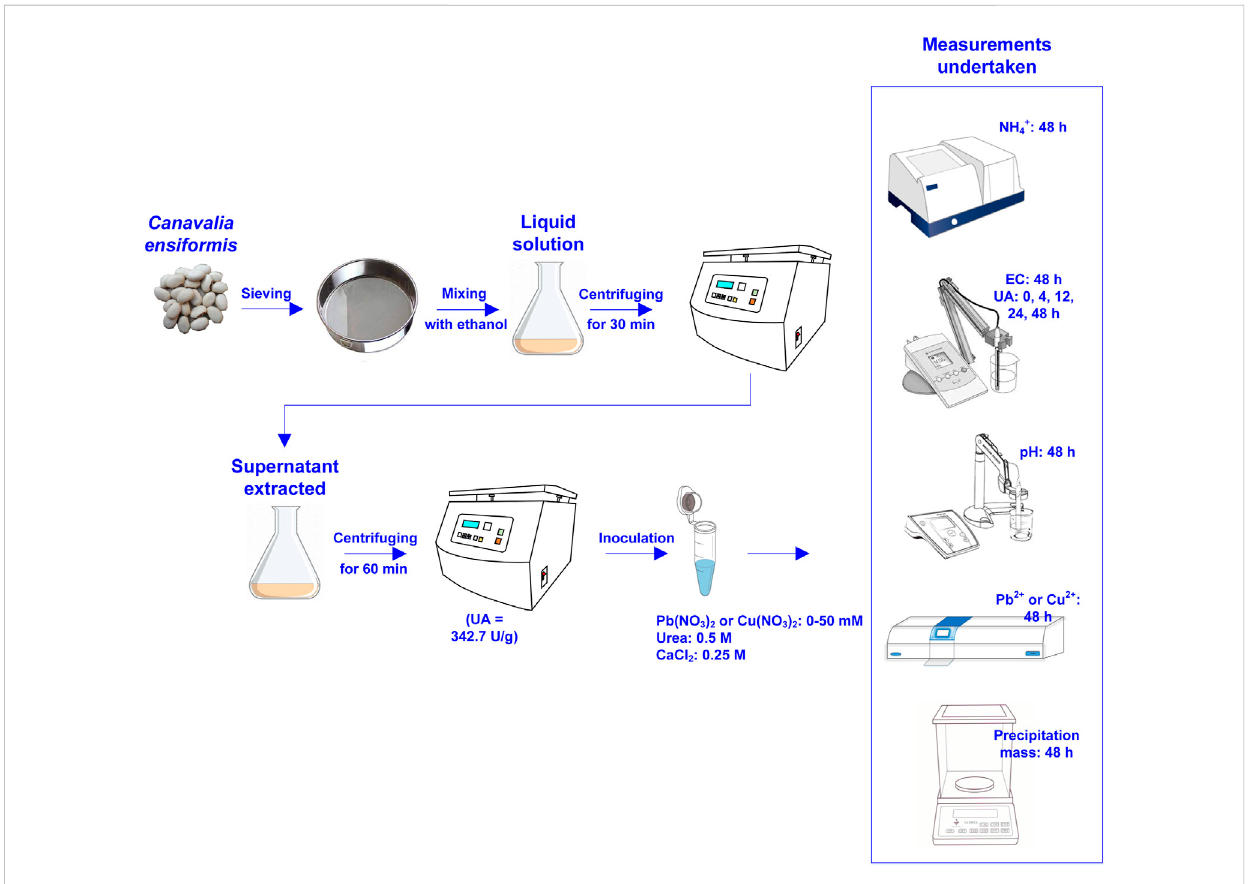
Flowchart of the test tube experiments applied to Pb or Cu remediation using the enzymatic-induced carbonate precipitation.